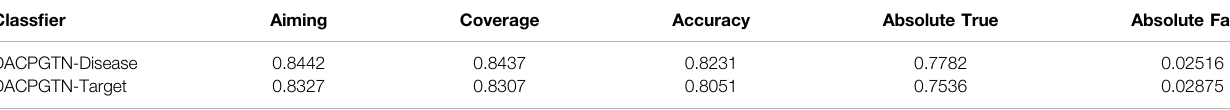
TABLE 5 | Experimental results of single-source interaction information. Class fi er Aiming DACPGTN-Disease